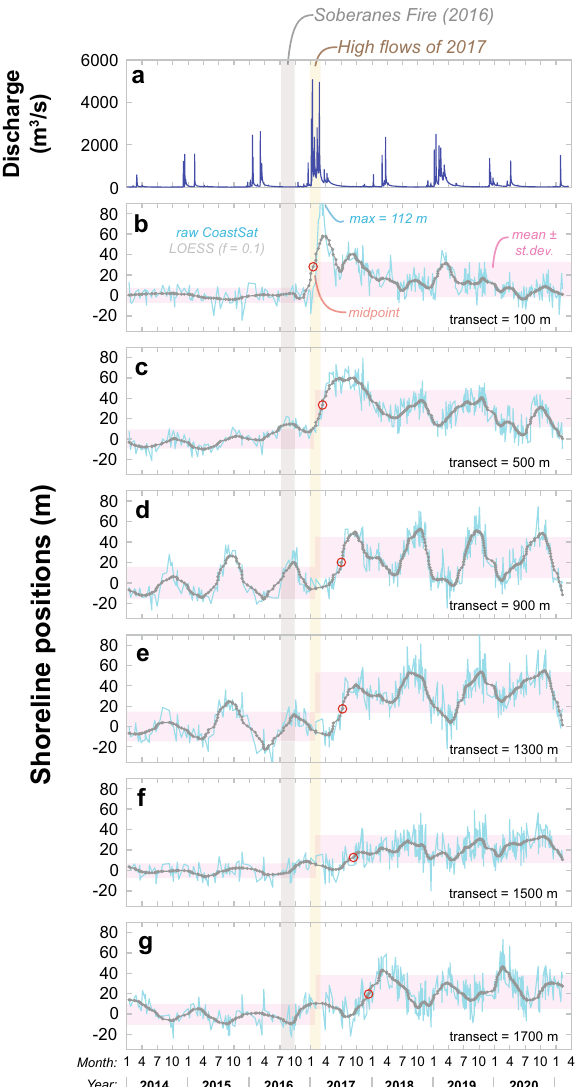
Figure 3. Detailed comparisons of Big Sur River discharge and CoastSat shoreline positions for six transects in the study area highlighting the years immediately before and after the 2016–2017 fire–flood event. The timing of the Soberanes fire and the highest river flow rates are highlighted with vertical bars. ( a ) Instantaneous river discharge from 15-min observations at the Big Sur River at Big Sur gauge (USGS streamgage 11143000). ( b – g ) Shoreline positions for six transects, including the raw CoastSat observations (blue lines), a LOESS-smoothed function through these observations (grey lines), and the mean ± st. dev. of the raw shoreline positions during the intervals before and after the peak in water discharge (pink boxes; see “Methods”). Also shown are the timing of the midpoint of the initiation of accretion (red symbols; see “Methods”). Note that the widest observation for the 100 m transect was off the figure scale. A complete set of plots for all transects is provided in the Supplemental